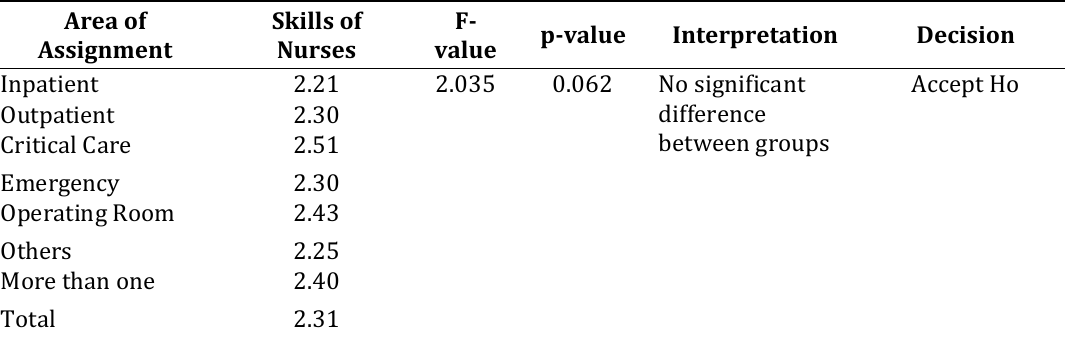
Differences in the responses of participants related to the skills of nurses when grouped according to area of assignment